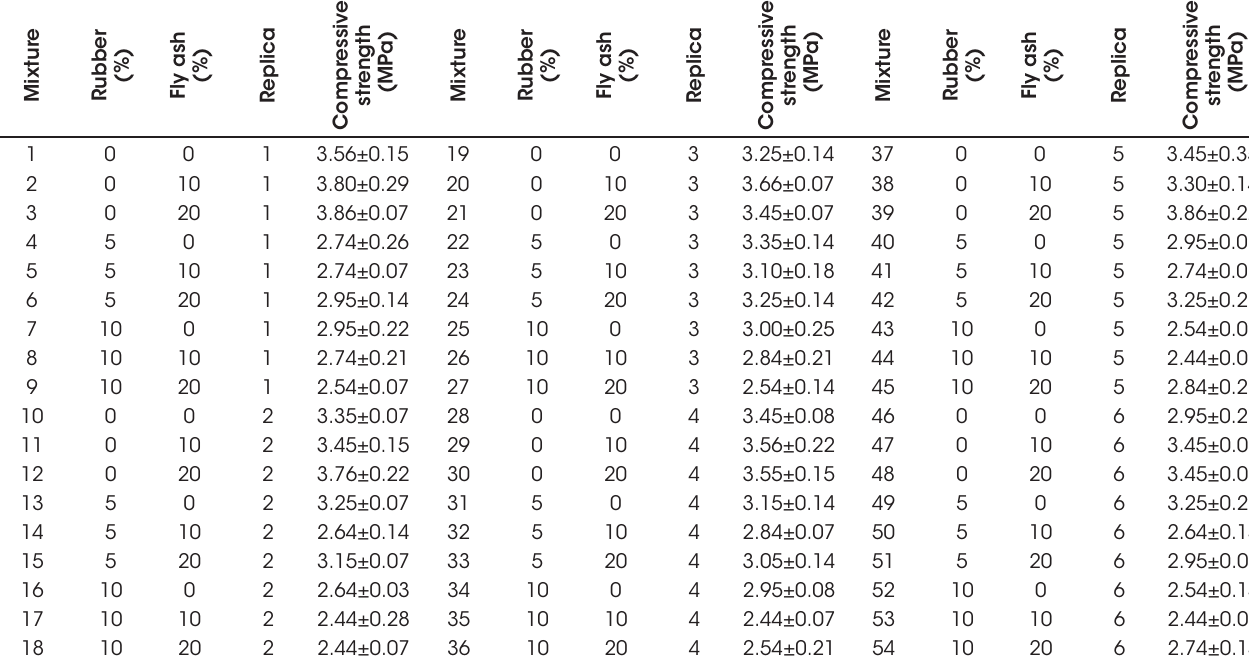
Mixtures of 3² factorial project compressive strength of